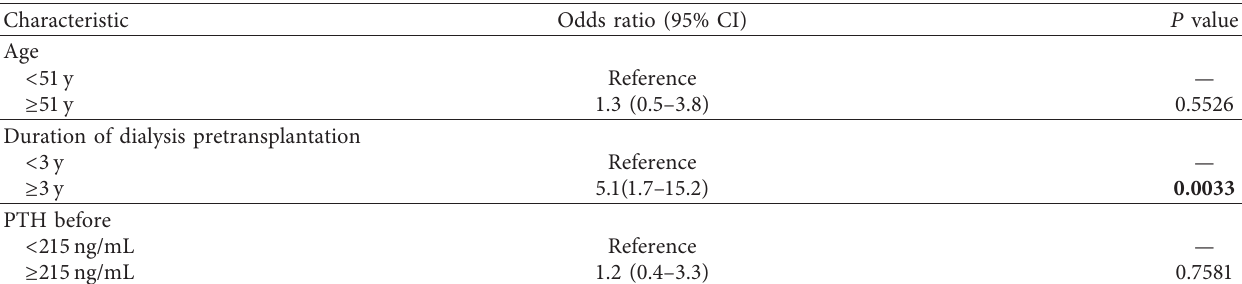
Table 4: Predictors for persistent